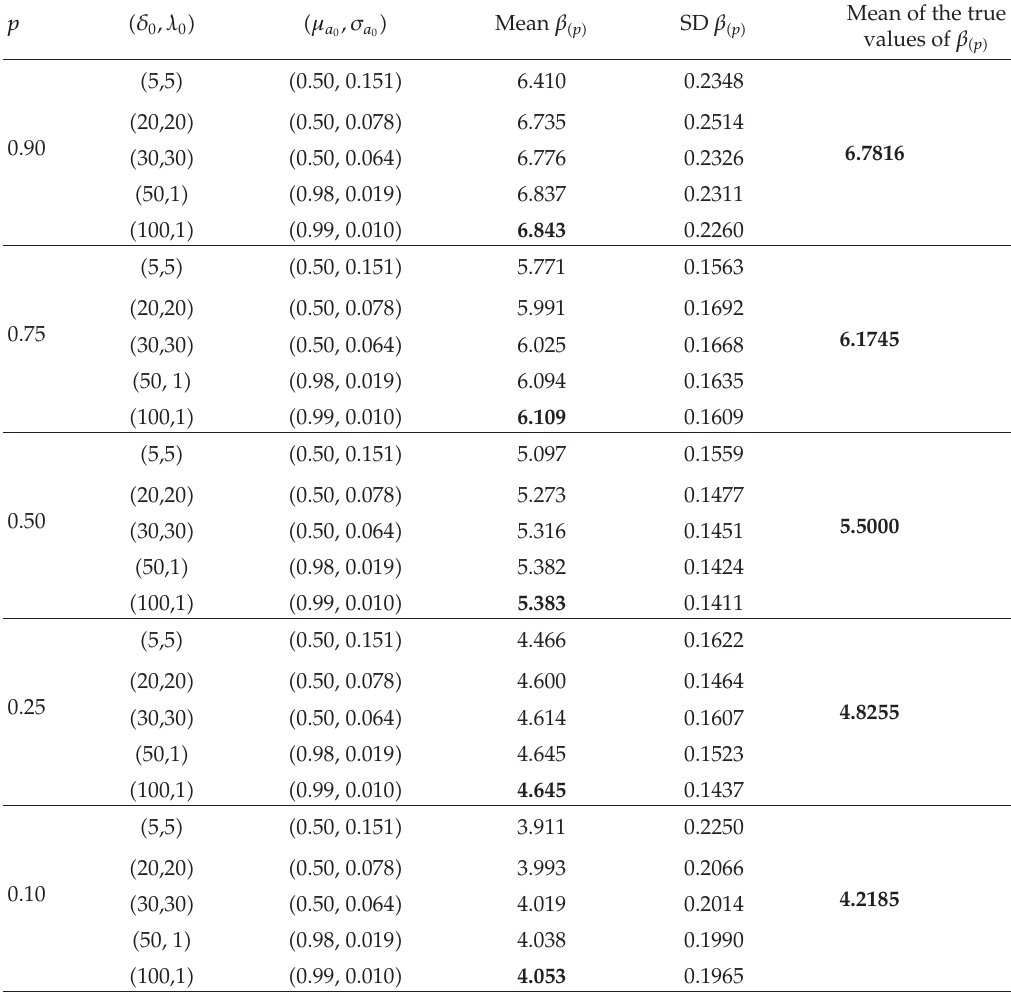
Table 1: Posterior means, posterior standard deviations (cid:2) SD (cid:5) , and mean of the true values of β (cid:2) p (cid:5) .